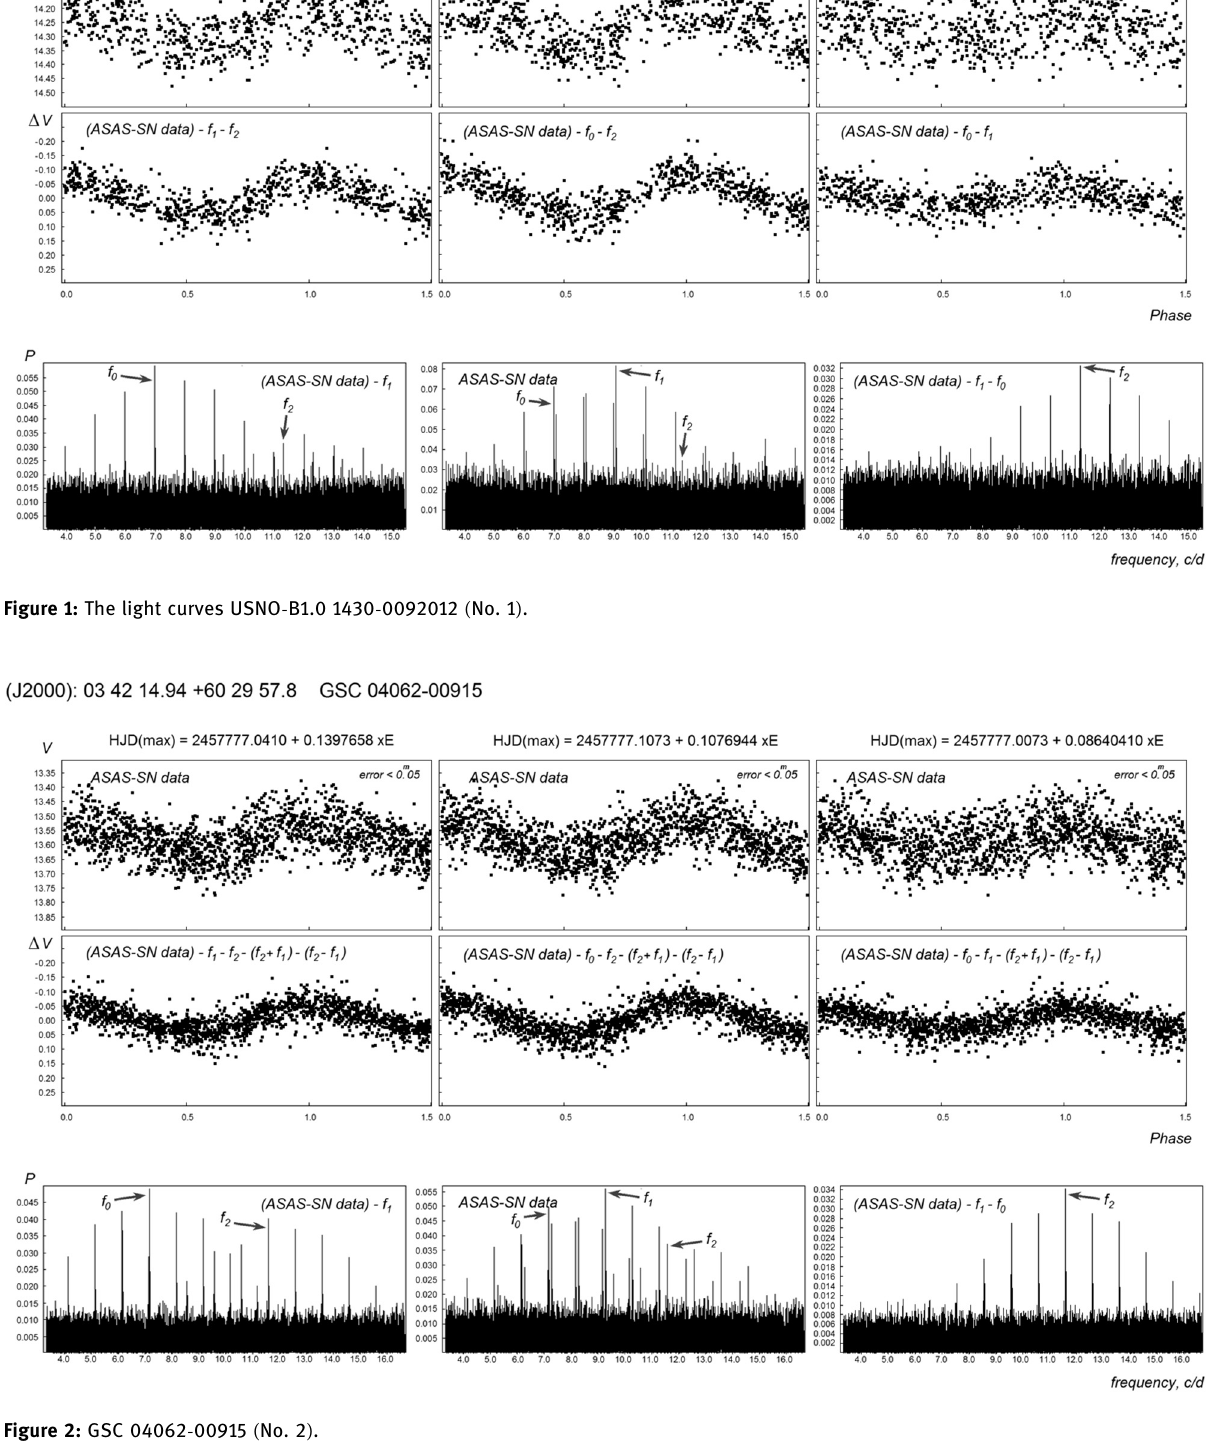
Figure 2: GSC 04062 - 00915 ( No. 2 )